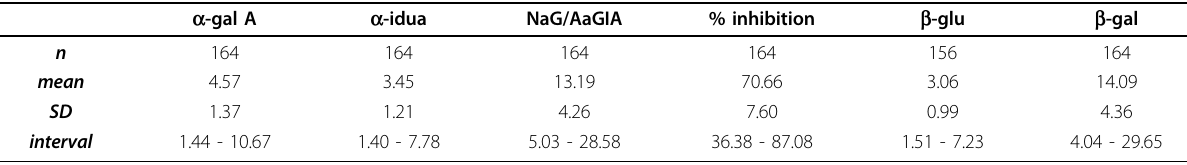
Table 2 Enzyme activities from HV DBS samples a -gal A a